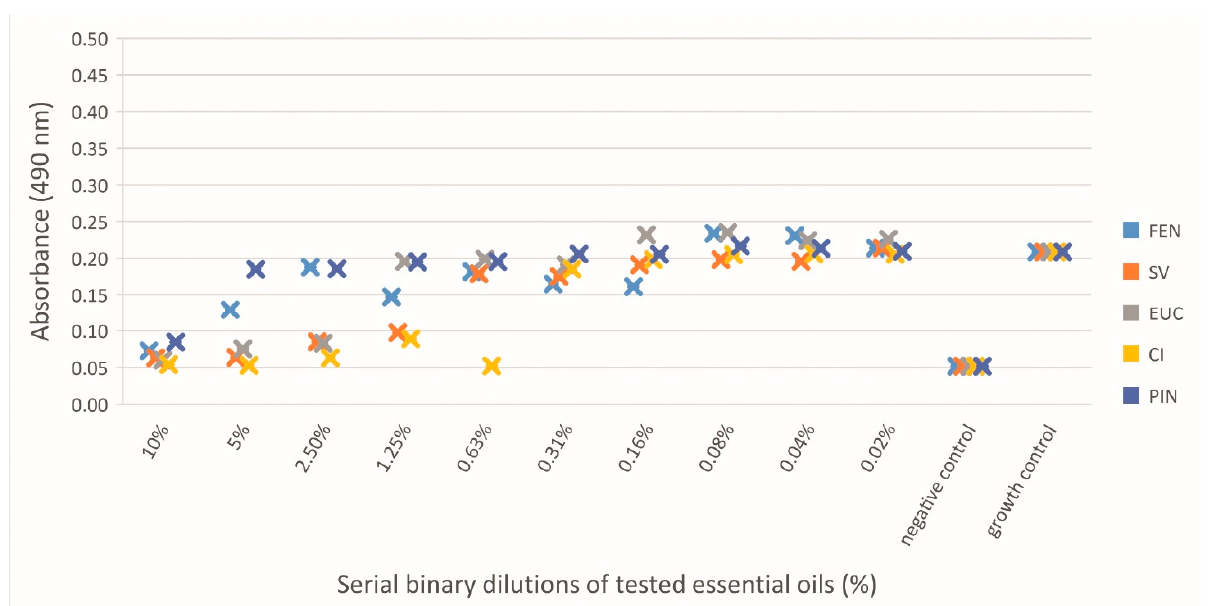
Figure 9. Graphical representation of the MCBE values for Gram-negative strain Pseudomonas aeruginosa ATCC 27853; FEN (fennel EO); SV (sage EO); EUC (eucalyptus EO); CI (thyme EO); PIN (pine EO).